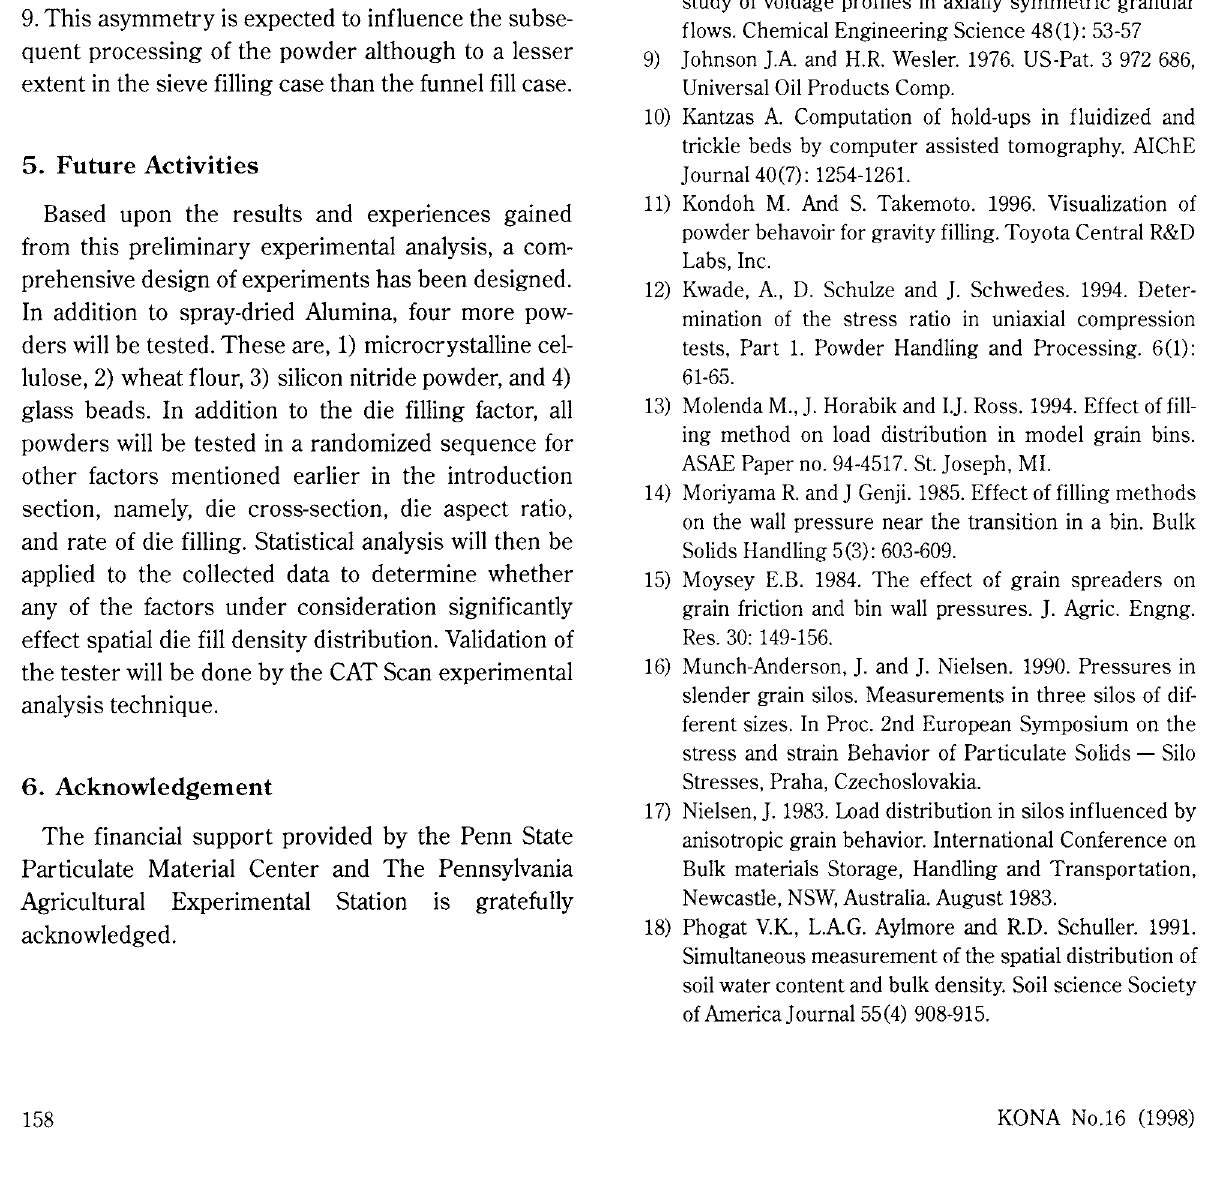
Fig. 9 Comparison of cumulative mass profile across the load cells at the end of die filling process by the funnel fill and sieve fill methods (die radius r=33